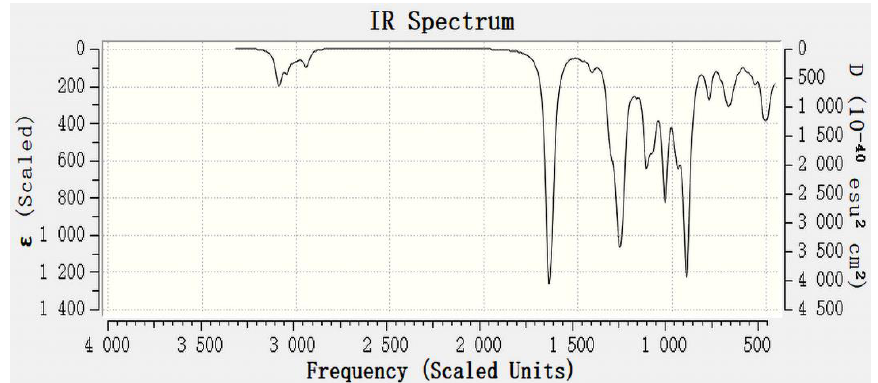
Figure 10. Calculated FTIR spectrum of Y 2 (CEPPA) 3 .